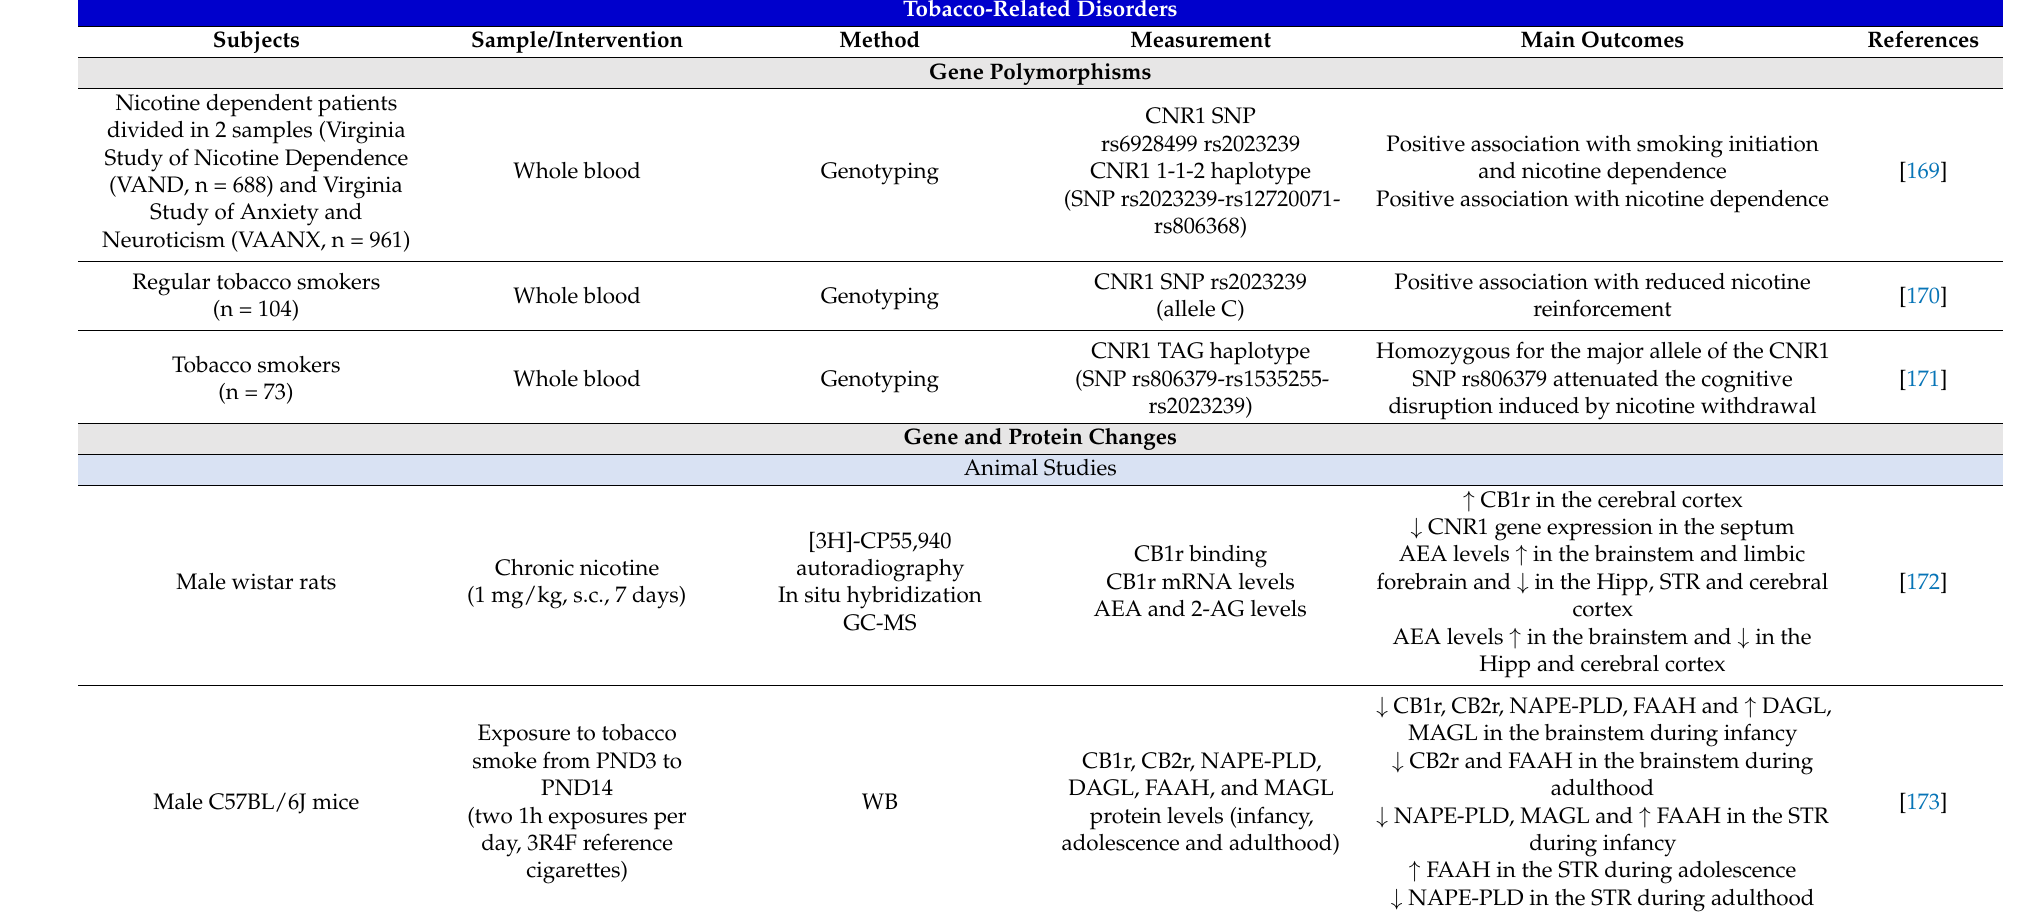
Table 5. Main findings from human and animal studies aiming to identify the alterations of ECS components in tobacco-related